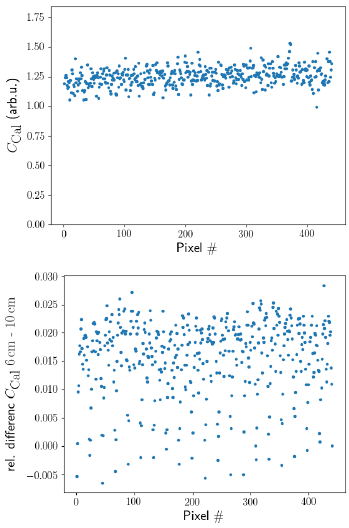
Figure 3. Calibration constants for the 440 pixels of a FD camera in arbitrary units for a sample scan grid size of 6 cm (upper plot) and the difference between this and 10 cm scan grid (lower plot).